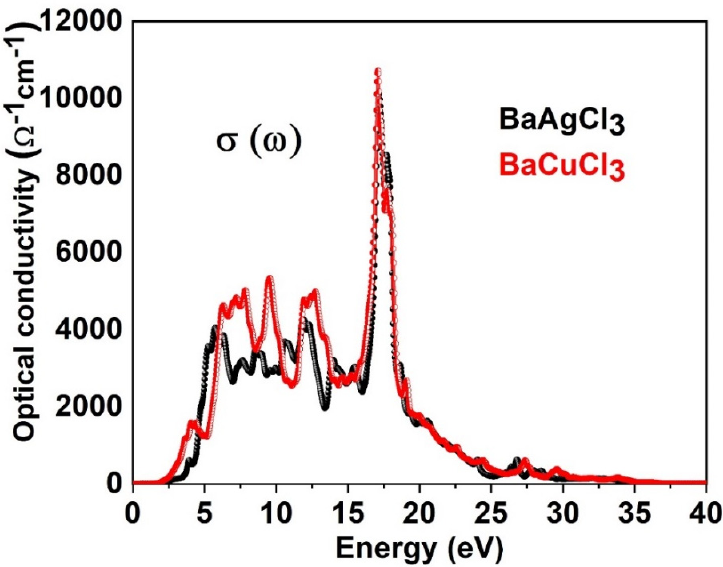
Figure 10. The optical conductivity of ternary BaAgCl 3 and BaCuCl 3 chloroperovskites compounds. The maximum value of optical conductivity is found at 10,200 at 17.25 eV and 10,700 at 17.13 eV, respectively. The materials show conductance in the 5 eV to 20 eV energy